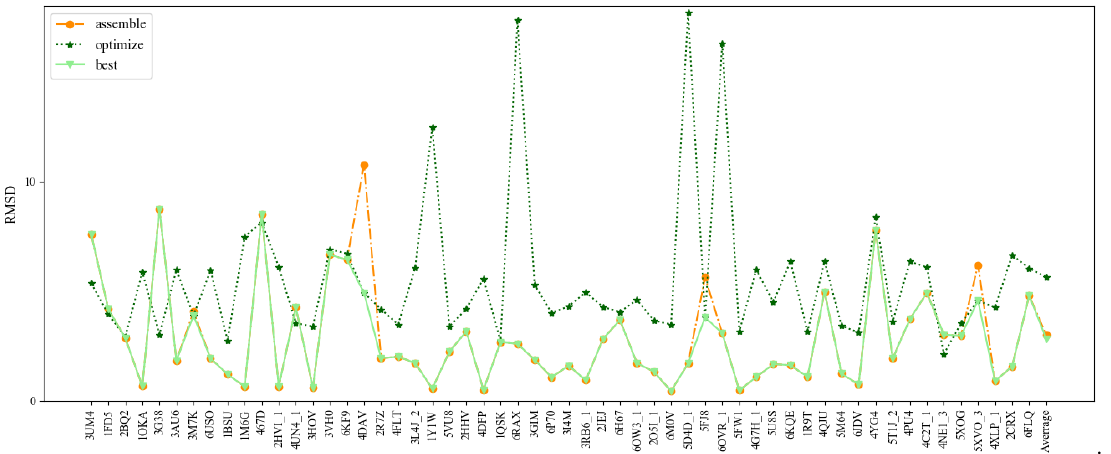
Figure 4. Comparison of the prediction accuracies (all-atom RMSDs) of 3dDNA for the assembled, optimized, and best structure of double-chain DNAs, respectively. Table 2. Information and prediction accuracies (RMSD in Å ) of 56 double-chain DNAs.